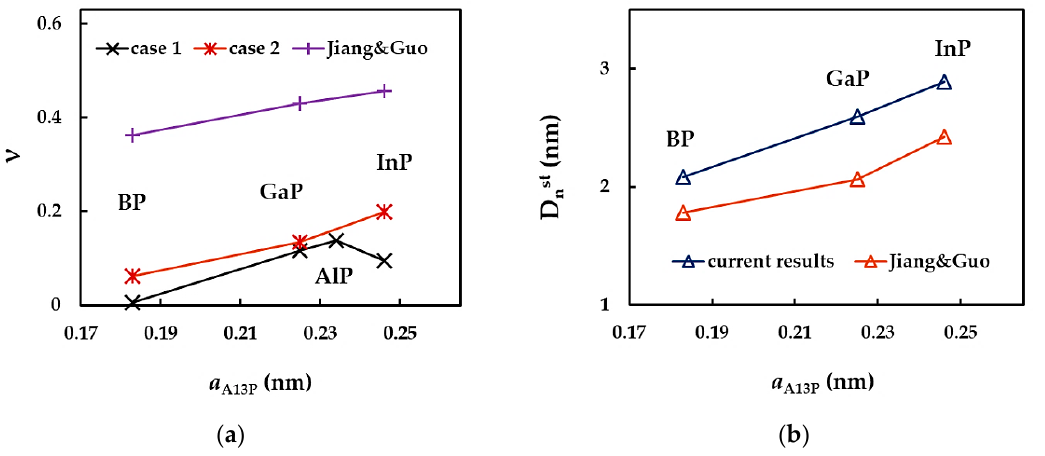
Figure 19. Evolutions of the: ( a ) Poisson´s ratio, ν , and ( b ) NT diameter, D nst , for which the value of ν becomes stable, as a function of the bond length, a A13 − P .